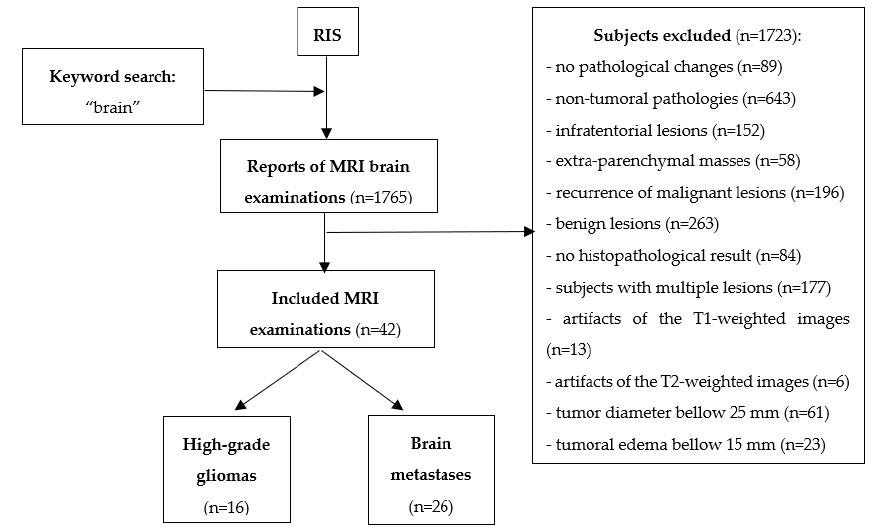
Figure 1. Patients. RIS, radiology information system; MRI, magnetic resonance imaging.